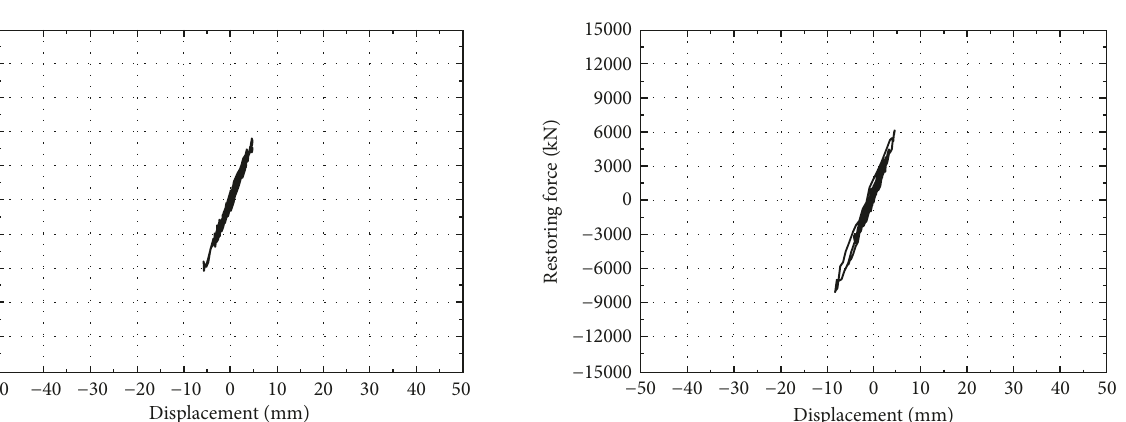
Figure 24: Hysteresis curve of intensity 7 frequently of Imperial Valley (longitudinal input).